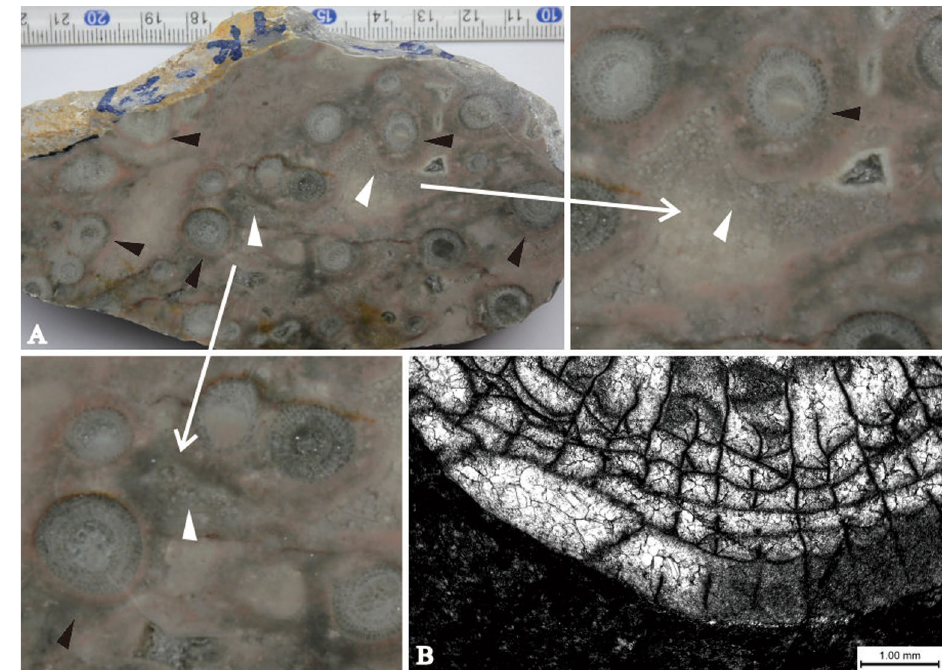
Figure 8. Micrographs of microbes and algaes. ( A ) Encrustations (indicated by black arrows) with distinct thickness around coral clusters formed by microbe and algal mats through bonding mud. The encrustations were formed before the clastic deposition (indicated by white arrows), showing the corals were living then. Microbes and algaes inside of the dense coral clusters had little impact on corals. ( B ) Single polarized micrograph showed clear and smooth boundaries of coral individuals without encrustation or drilling hole made by microbes or algaes. Few corals surrounded by bonding algaes could be observed in Langping, indicating that algaes were poorly developed between coral clusters. This figure is modified by the author from field photos with CorelDRAW (version 2022, and the URL link: https:// www. corel draw. com/